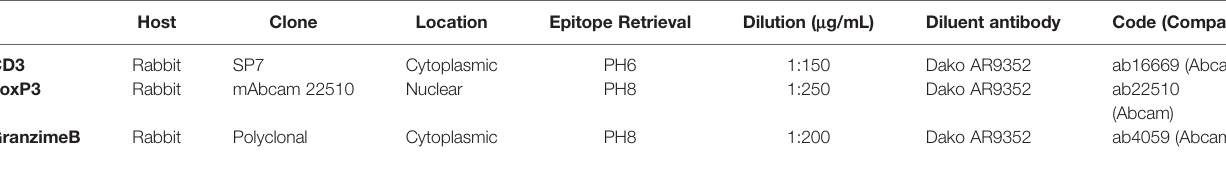
TABLE 1 | Manufacturers and condition use of primary